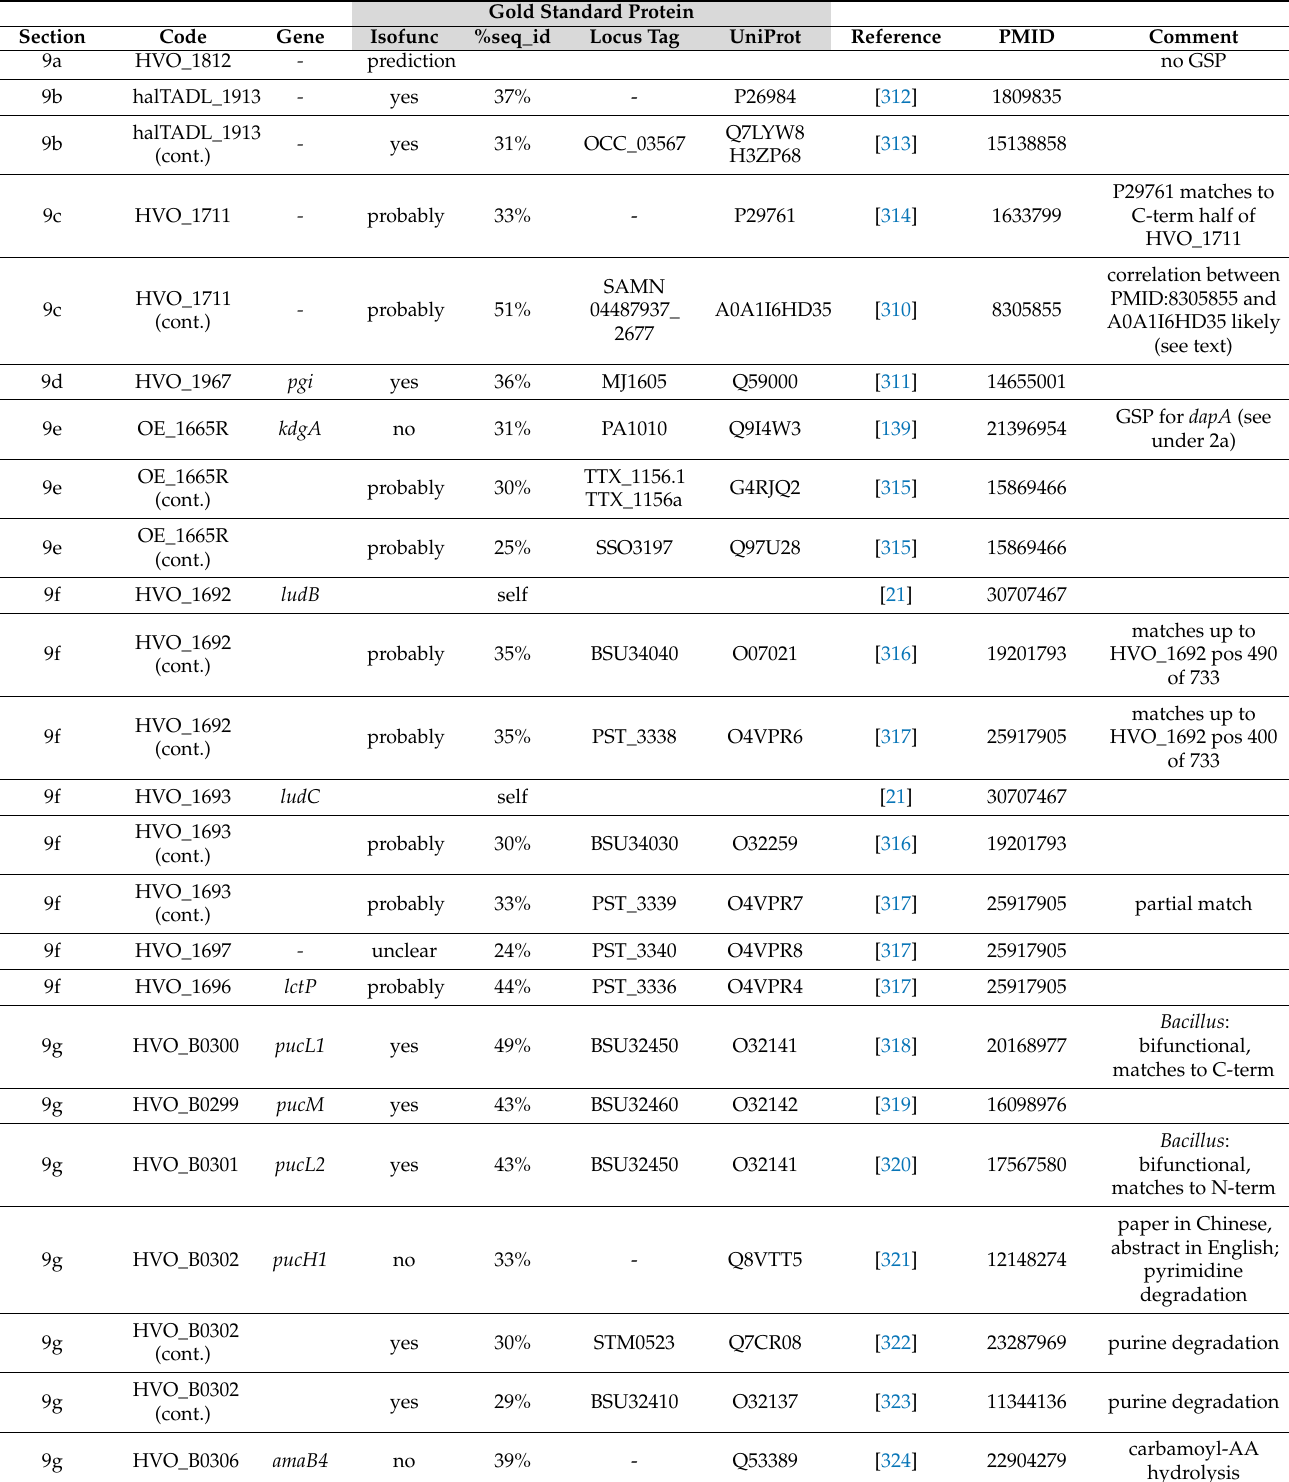
Table 9. Proteins with open annotation issues and their Gold Standard Protein homologs (Section 3.9). For a description of this table, see the legend to Table